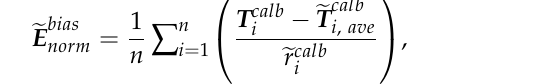
noise C from (cid:101) T